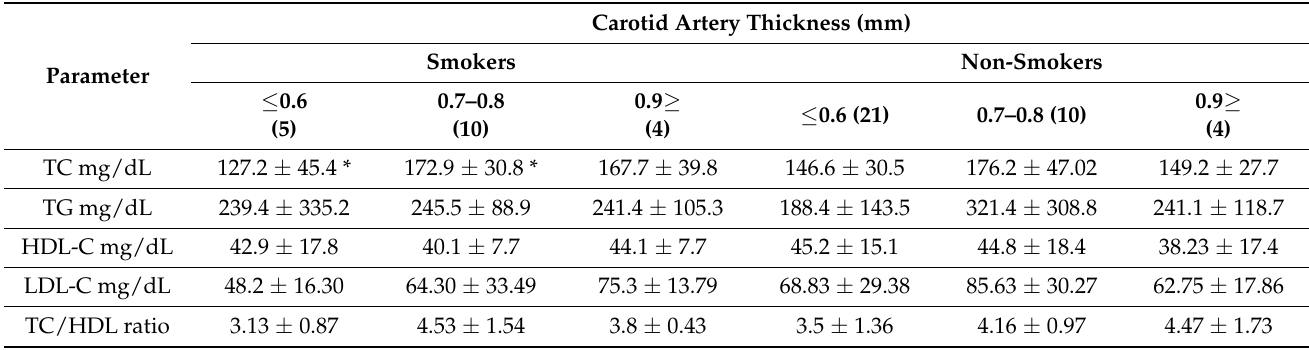
Table 6. Mean values of studied parameters in smokers and non-smokers, according to carotid artery